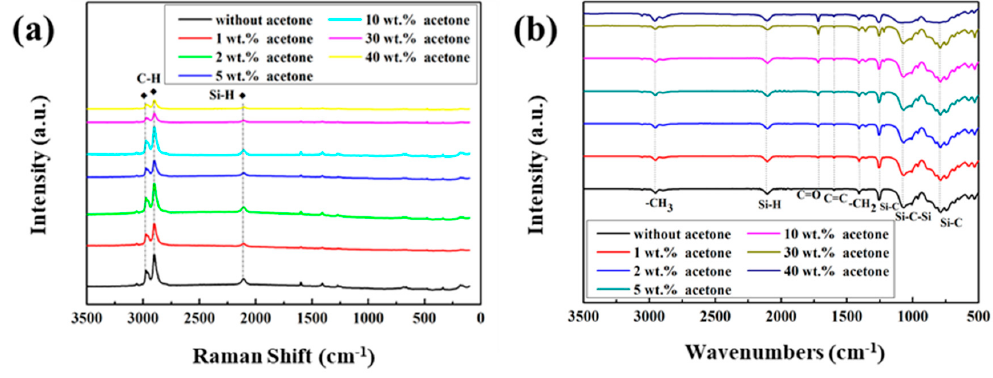
Figure 7. Raman and Fourier transform infrared spectroscopy (FT-IR) spectra of L-PCS solutions with di ff erent acetone content. ( a ) Raman spectra, ( b ) FT-IR spectra.